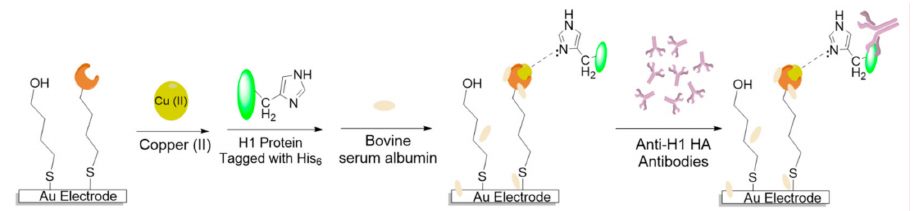
Figure 2. Schematic representation of electrochemical immunosensor for detection of anti- hemagglutinin (HA) antibodies. Au electrode modification with a mixture of 4-Mercaptobutanol (MBT) and dipyrromethene (DMP) followed by addition of Cu (II), His6-H1 HA tag, and Bovine serum albumin (BSA). The resulting His6-H1 HA/DMP/Cu (II) complex is able to detect anti-HA antibodies. Adapted from Mikuła et al. [79] under Creative Commons Attribution